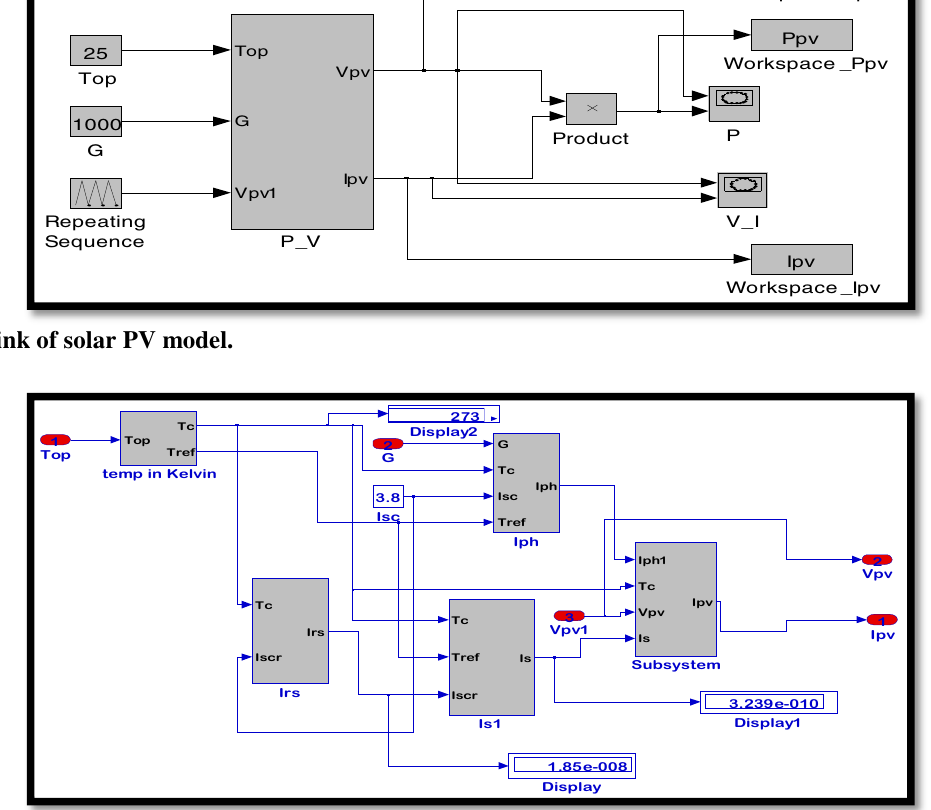
Fig. 5. Block PV-Module